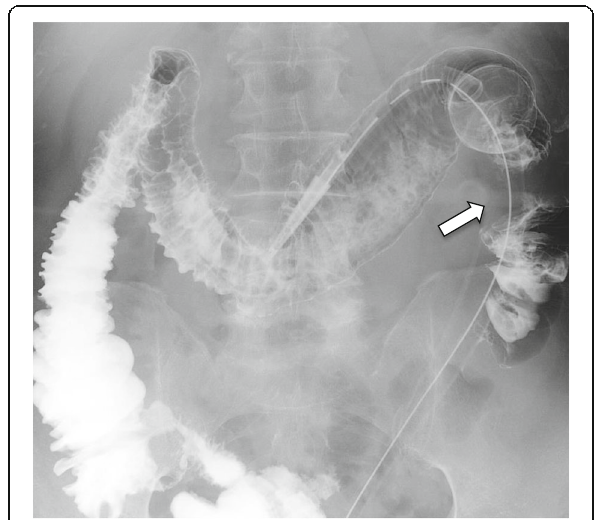
Fig. 1 Enema X-ray before operation. Enema X-ray showed light narrowing and a rough mucosal surface in the transverse colon. The arrow shows transverse colon cancer